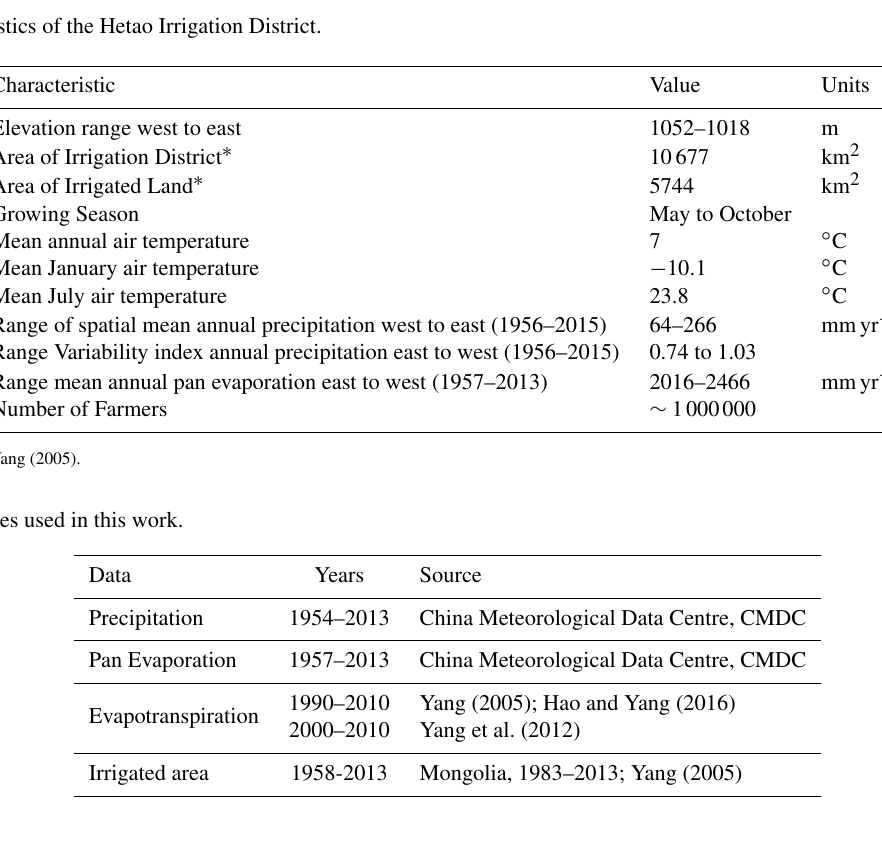
Table 3. The five climate stations used to assess precipitation across Hetao (west to east) for the period 1957 to